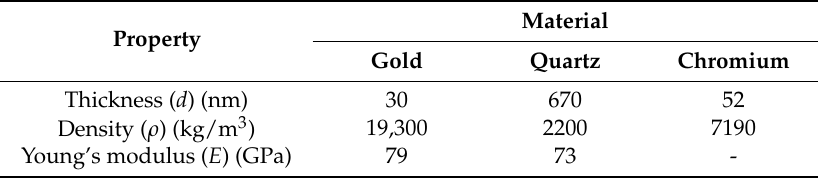
Table 1. Material properties used in the analytical estimation.